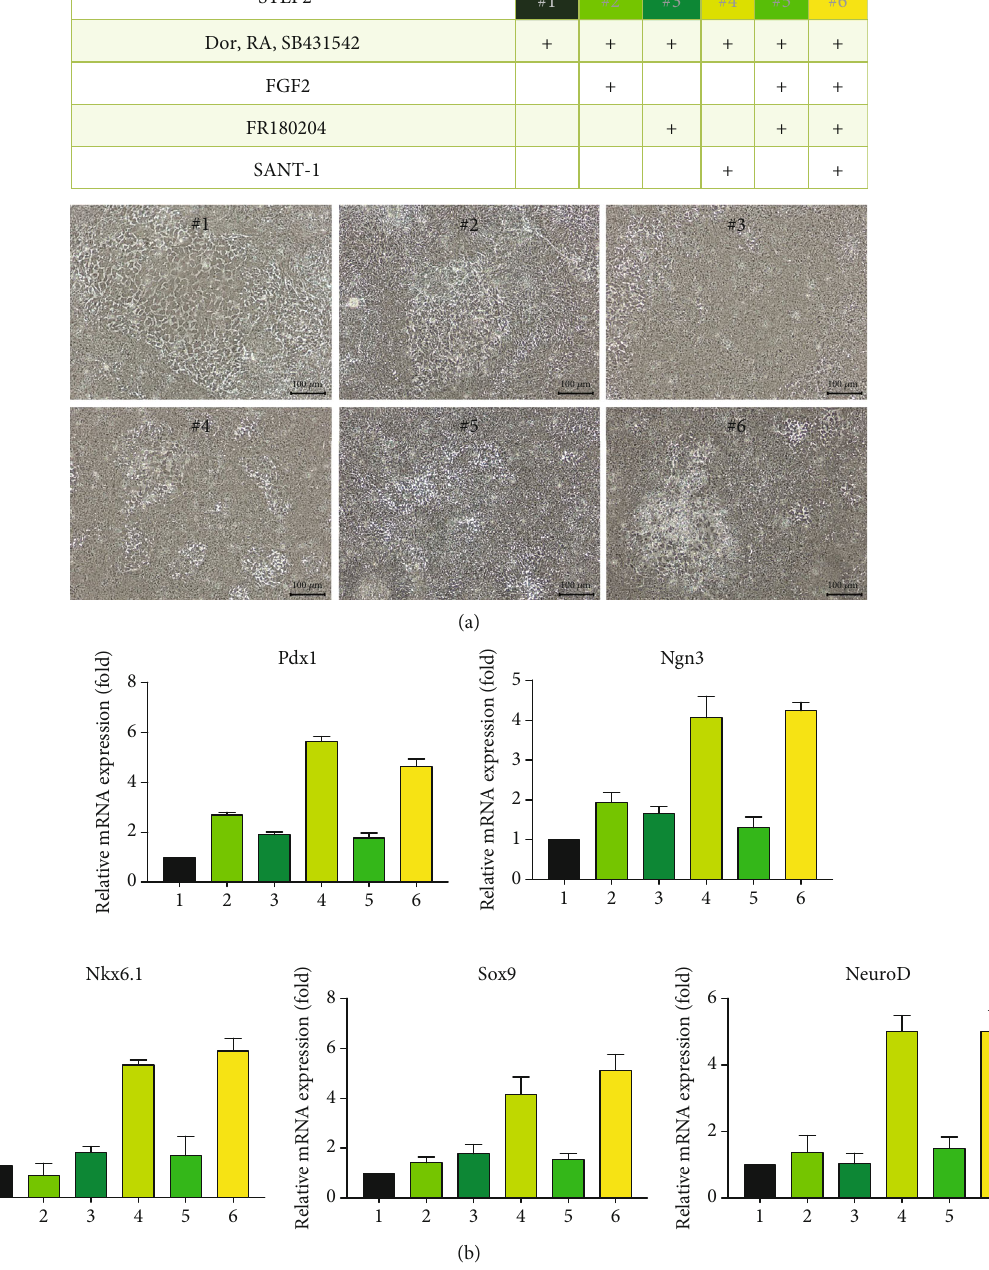
Figure 3: Combinations of small molecules to di ff erentiate cells into pancreatic progenitor cells. (a) Combinations of small molecules applied in three stages to induce di ff erentiation into islet precursor cells. Cell morphology is homogeneous in groups 4 and 6, in which SANT-1 was added to basic di ff erentiation culture medium during step 3 of di ff erentiation. (b) The expression of major transcription factors in pancreatic progenitor cells under all conditions compared using qPCR. The expression of major transcription factors, Pdx1, Ngn3, Nkx6.1, Sox9, and NeuroD in other groups is slightly higher than that in group 1, which was incubated with only the basic di ff erentiation factor. Expression is the most abundant in cells incubated with SANT-1 ( n = 3